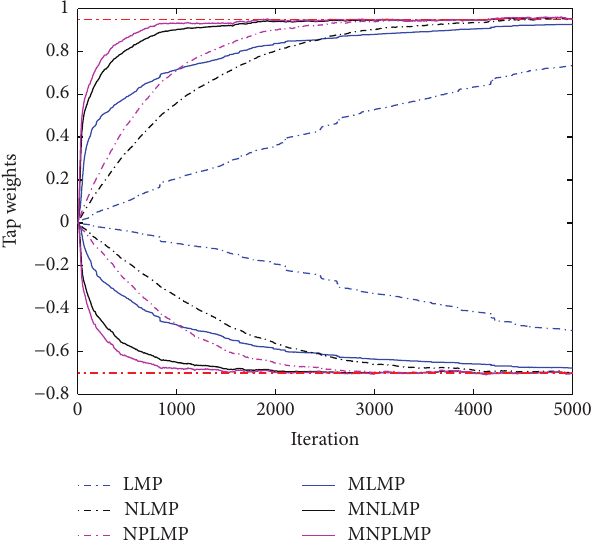
Figure 7: Weight convergence history of different approaches.